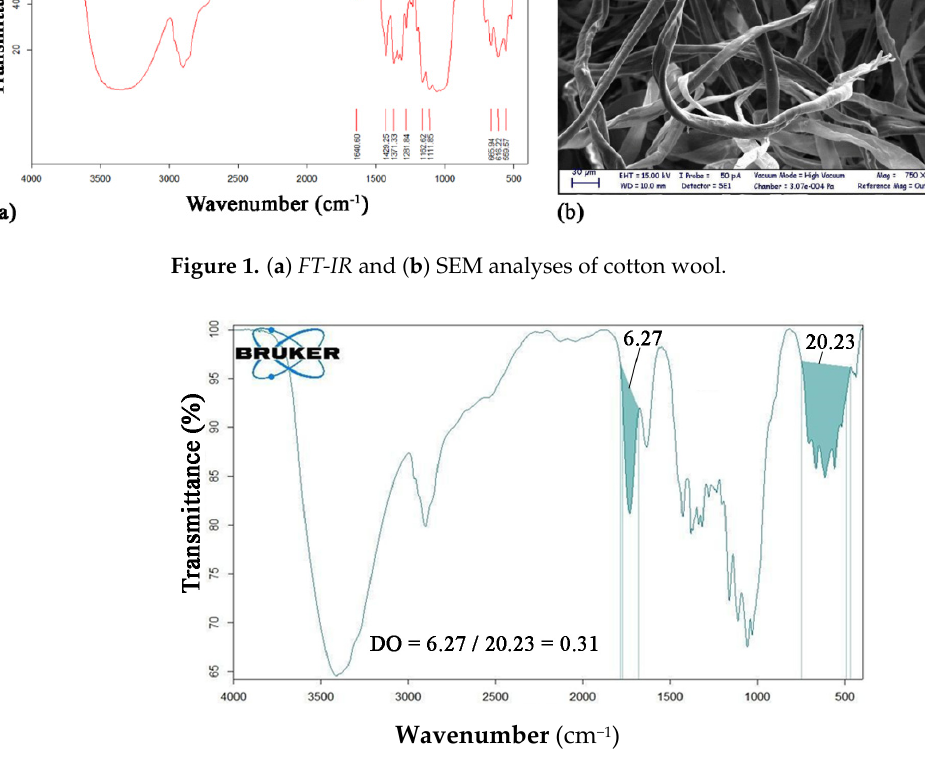
Figure 1. ( a ) FT-IR and ( b ) SEM analyses of cotton wool.